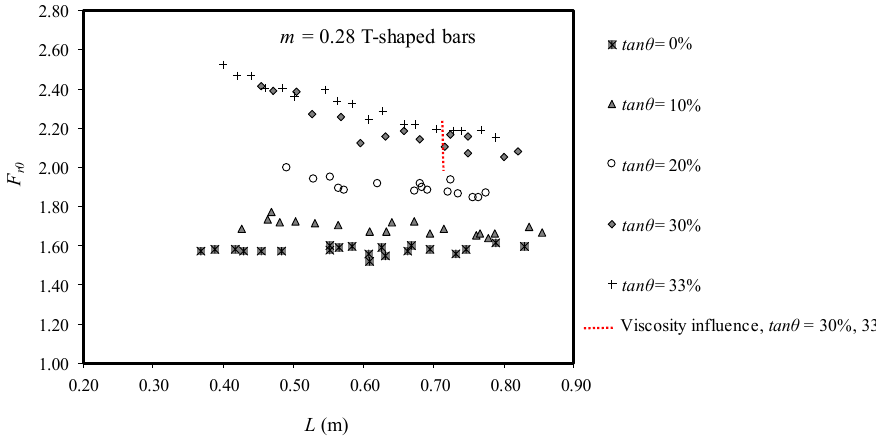
Figure 14. Froude number at the beginning of the rack F r 0 as a function of the wetted rack length L , for T-shaped flat bars with void ratio m = 0.28. Table 3. Viscosity influence in the flow depth at the beginning of the rack in the case of 30 and 33% longitudinal